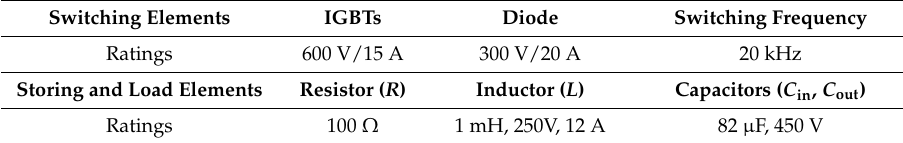
Table 2. Boost converter parameter specifications. IGBT: insulated gate bipolar transistor.